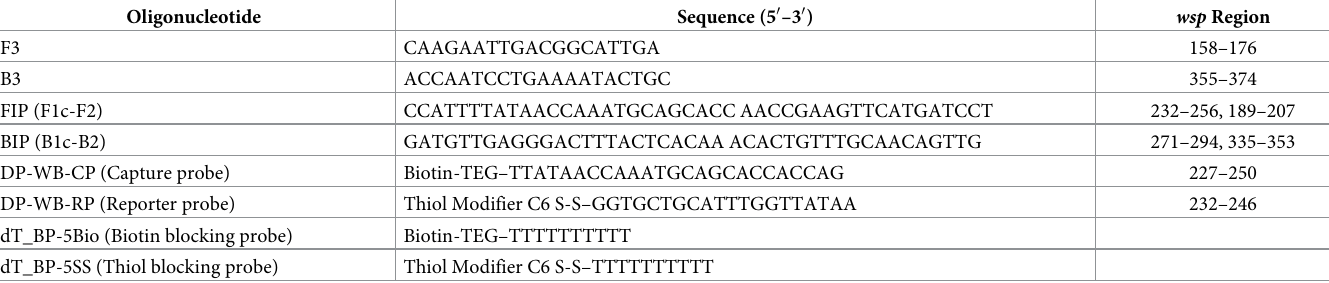
Table 1. Oligonucleotide sequences of LAMP primers and target induced-DNA strand displacement probes used in this study.